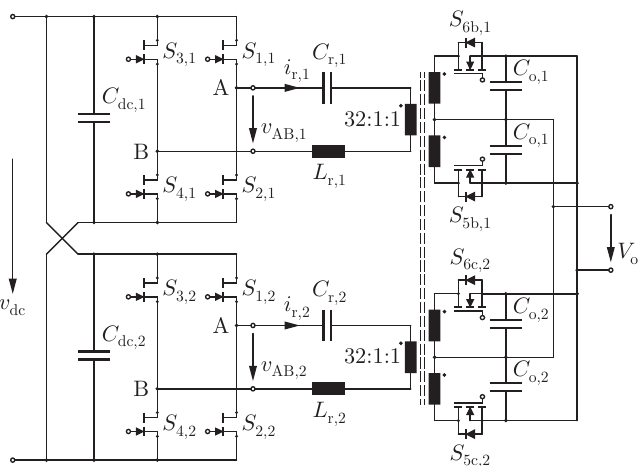
Figure 22. Simplified power circuit of the proposed input-parallel output-parallel (IPOP) combined DC/DC converter, with the snake-core transformer shared for a single flux path between the two modules that results in ideal current sharing, lower core losses, and improved power density. The converter utilizes GaN devices for the primary-side full-bridge and the updated IQE013N04LM6 power MOSFETs operating as synchronous rectifiers on the secondary-side.